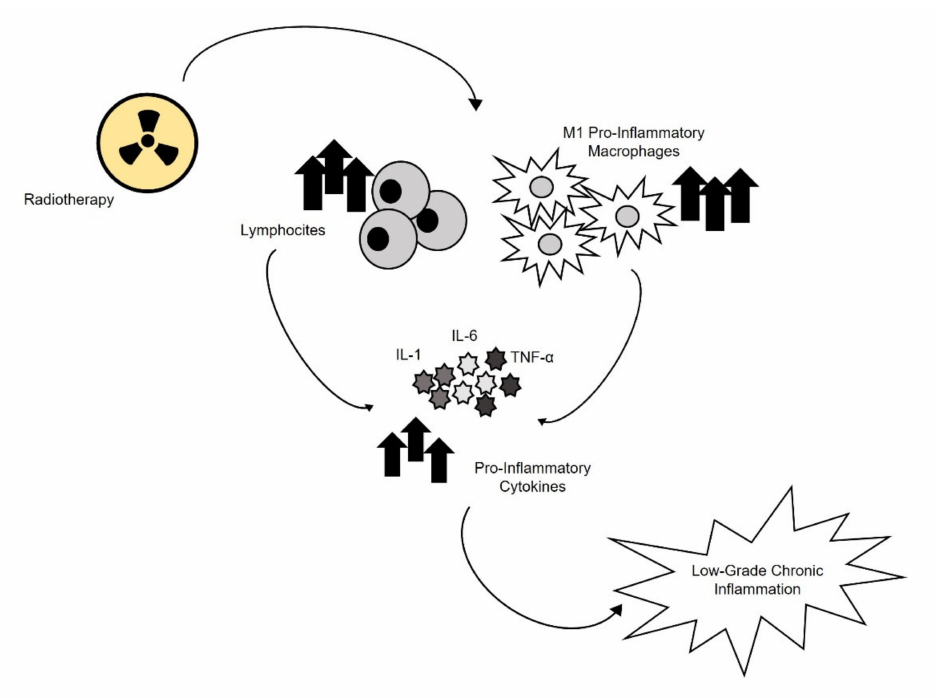
Figure 2. Radiation-induced immune response. Radiotherapy induces M1 pro-inflammatory macrophages and lymphocytes activation, leading to an increased production of pro-inflammatory cytokines, such as Interleukin (IL)-1, IL-6, and Tumor Necrosis Factor (TNF)- α , which contributes to the low-grade chronic inflammation, a typical condition of long-term cancer survivor